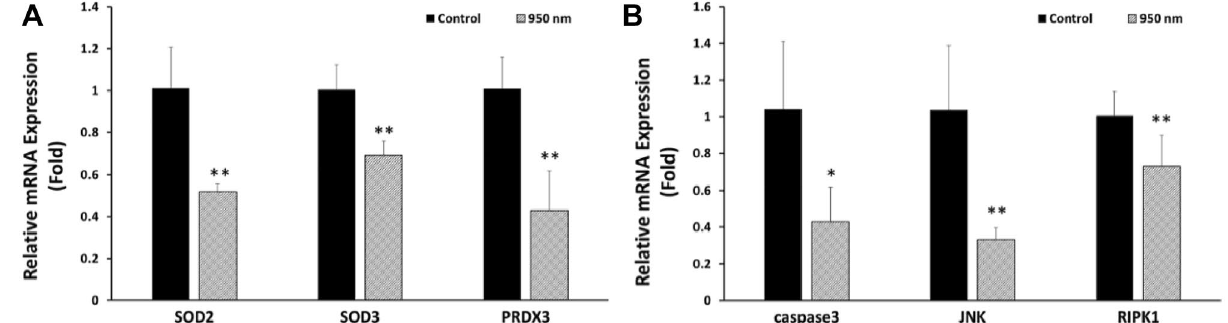
Figure 5. Relative mRNA expression of control and 950 nm -irradiated group. ( A ) SOD2, SOD3, and PRDX3 are related to oxidative stress. ( B ) Caspase 3, DUSP1, JNK, and RIPK1 are related to apoptosis. Data are mean ± SD (n > 5). * P < 0.05, ** P < 0.01 versus controls. P values were determined by one-way ANOVA ( A,B